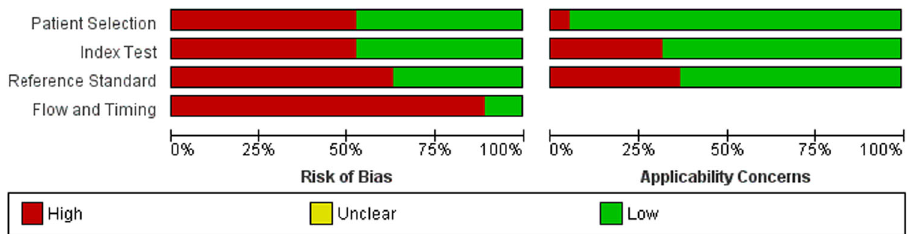
Fig. 3 Risk of bias and applicability concerns graph: review authors ’ judgements about each domain presented as percentages across included studies. High, unclear and low risk of bias or applicability concerns are represented as shown in the